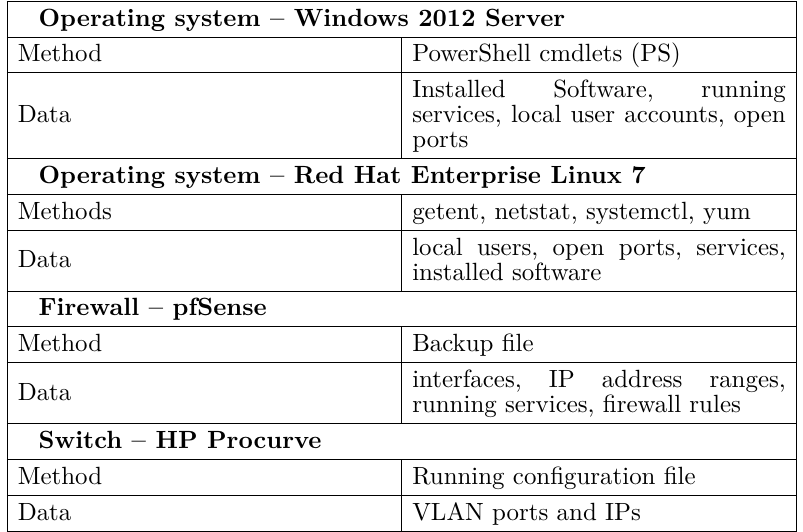
Table 6. Collected configuration data and collection methods for Windows 10 and Linux